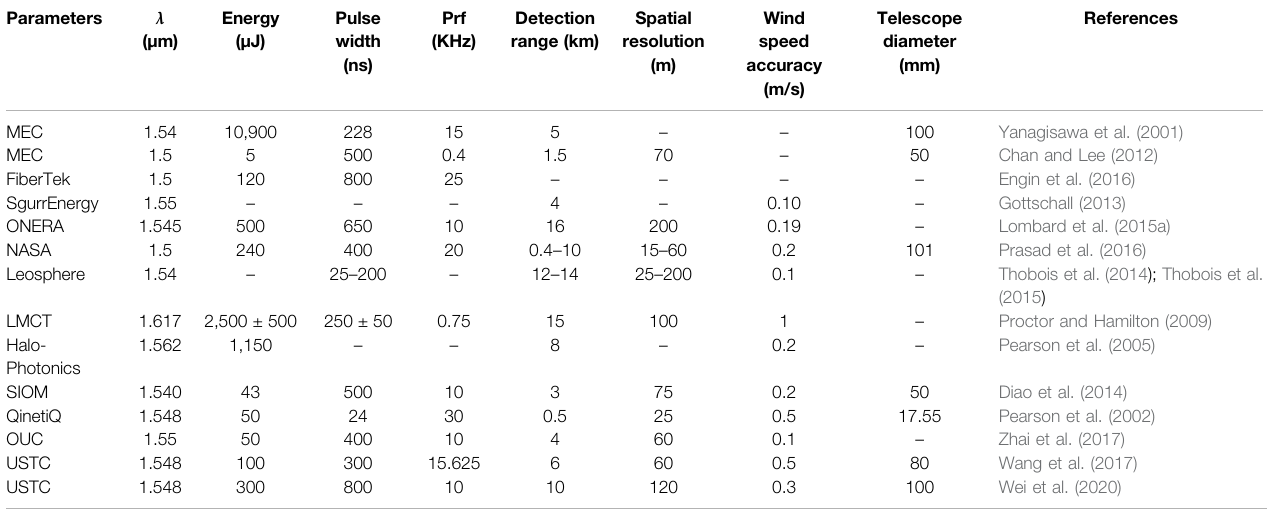
TABLE 2 | Performance of 1.5- μ m C-DWLs.